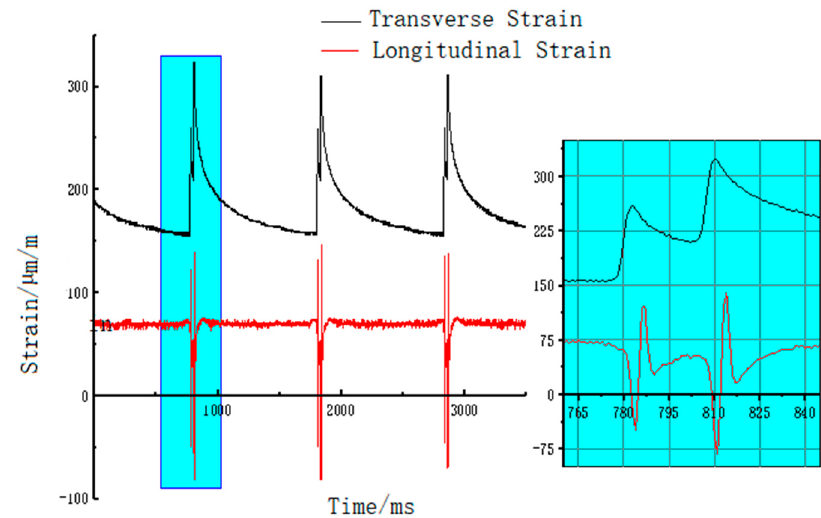
Figure 3. Transverse longitudinal strain at the base of the layer under biaxial